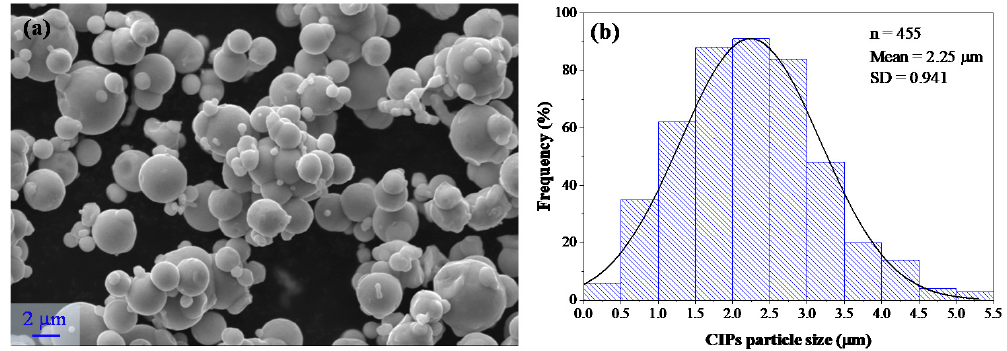
Figure 15. ( a ) Morphology of carbonyl iron particles (powder), and ( b ) diameter particle size distribution computed by using Digimizer 4.6.1 software (MedCalc Ltd.).